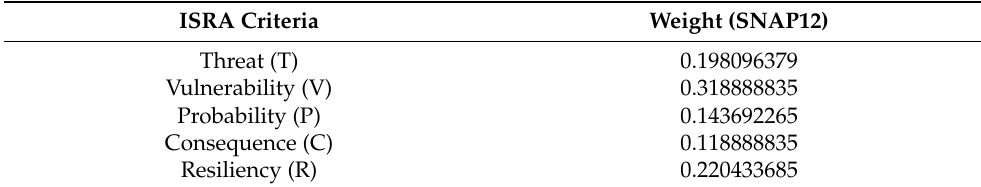
Table 1. Weights of generic ISRA elements obtained by SNAP12 method.